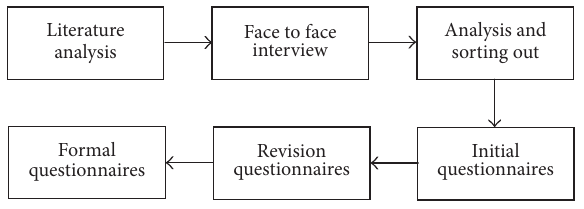
Figure 1: Questionnaire